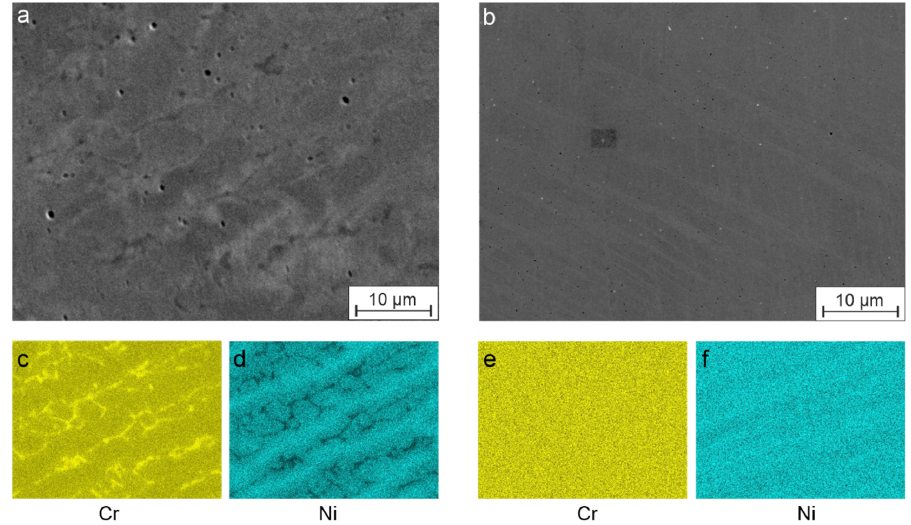
Figure 4. SEM-EDX mappings of the coating AISI 304 for alloying elements Cr and Ni in ( a ) as- cladded condition with elemental distribution of ( c ) Cr and ( d ) Nias well as ( b ) after heat treatment at 1100 ◦ C for 60 min with elemental distribution of ( e ) Cr and ( f )